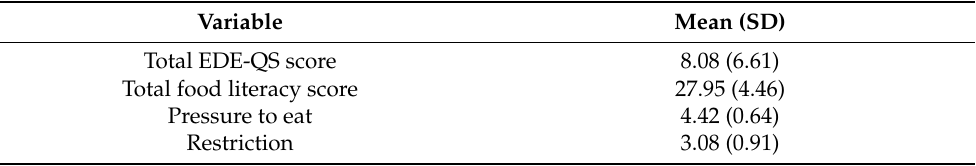
Table 2. Means and Standard Deviations on the Measures of Eating Disorder Examination, Food Literacy, Pressure to Eat and Restriction in Mothers ( n = 819).